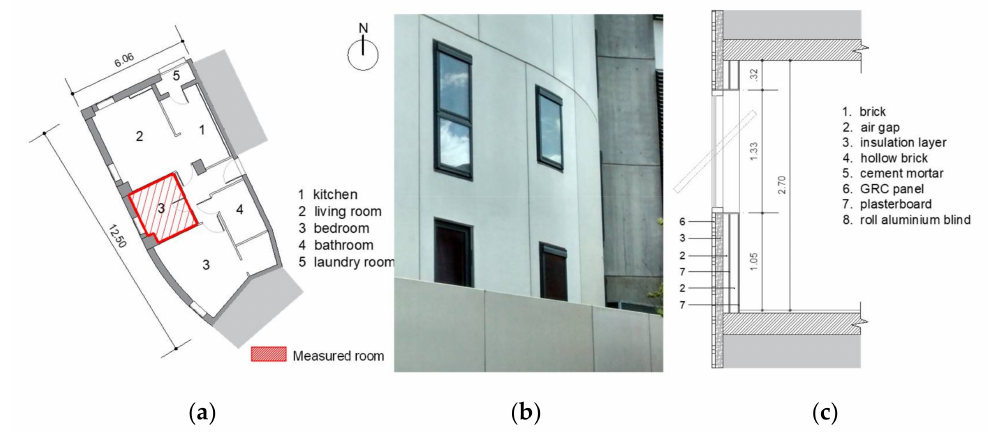
Figure 4. ( a ) Dw2’s plan; ( b ) Dw2’s façade’s picture; ( c ) Dw2’s façade section and its materials.